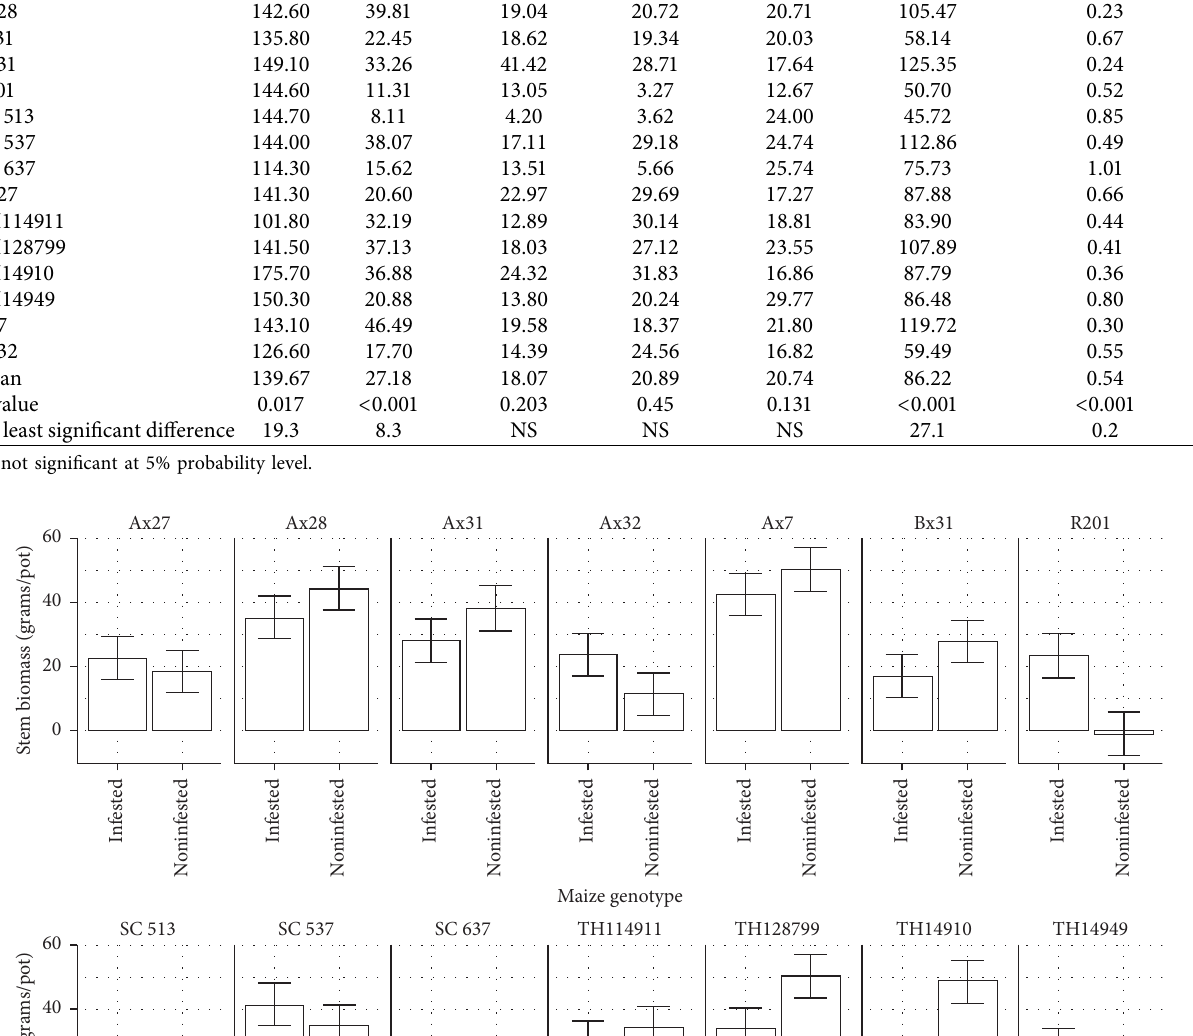
Table 4: Means of maize traits recorded during a greenhouse experiment at the University of Zimbabwe. Genotype